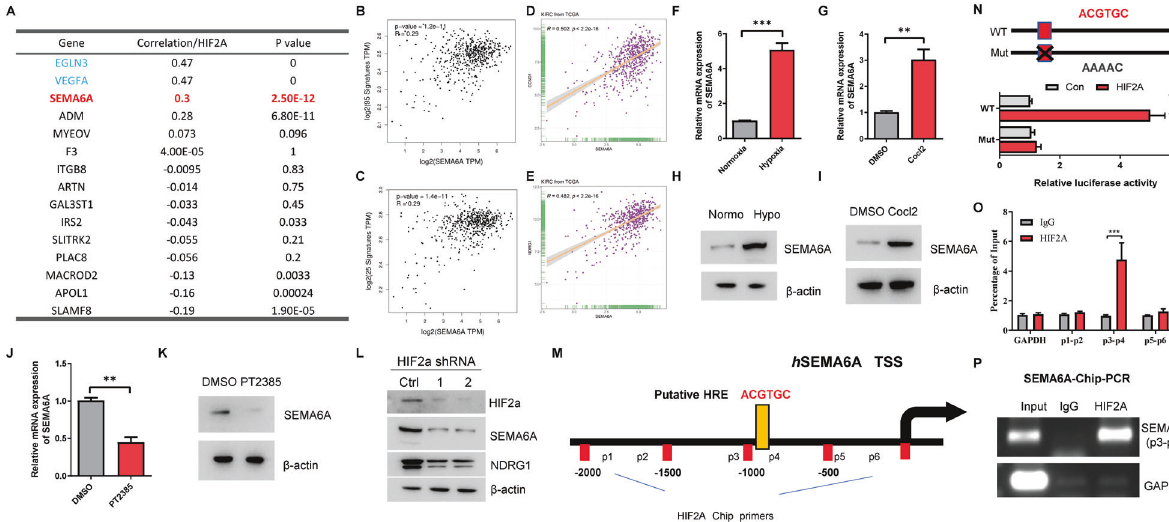
Fig. 2 SEMA6A is a transcriptional target of HIF-2 α in ccRCC. A mRNA correlation between the mRNA level of HIF-2 α and its 15 putative target genes in TCGA KIRC dataset was analyzed using the GEPIA platform (http://gepia2.cancer-pku.cn/). B The mRNA correlation between SEMA6A and 95 hypoxia metagenes in the TCGA KIRC database. C The mRNA correlation between SEMA6A and 25 hypoxia metagenes in the TCGA KIRC database. D mRNA correlation between CCND1 and SEMA6A in the TCGA KIRC database. E mRNA correlation between NDRG1 and SEMA6A in the TCGA KIRC database. F , G Relative mRNA and protein levels of SEMA6A in A498 cells under either normoxia or hypoxia conditions. *** p < 0.001. H , I Relative mRNA and protein levels of SEMA6A in A498 cells in response to CoCl 2 treatment. ** p < 0.01. J , K Relative mRNA and protein levels of SEMA6A in A498 cells in response to PT2385 treatment. ** p < 0.01. L Protein levels of HIF-2 α , SEMA6A , and NDRG1 in A498 cells transfected with control shRNA or shRNAs targeting HIF-2 α . M Schematic representation of the human SEMA6A gene promoter and the putative HIF-2 α binding site. TSS transcription start site. N Human SENA6A promoter contains a potential HIF-2 α binding site, highlighted in red. Mutant sites are marked with a cross. FLAG- HIF-2 α was co-transfected with the indicated plasmids into 293T cells for 36 h. Luciferase activity was then measured. *** p < 0.001. O ChIP-qPCR assay showed the enrichment of HIF-2 α in the putative HIF-2 α binding site of the SEMA6A promoter region. *** p < 0.001. P ChIP-PCR assay showed the occupation of HIF-2 α in the putative HIF-2 α binding site of the SEMA6A promoter